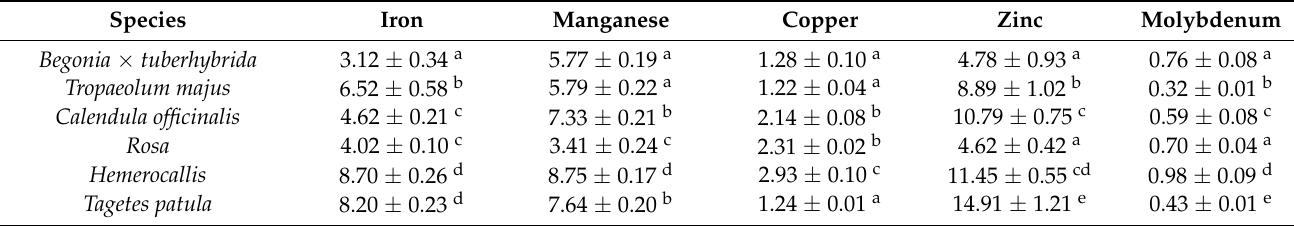
Table 5. Content of microelements in 6 species of edible flowers.